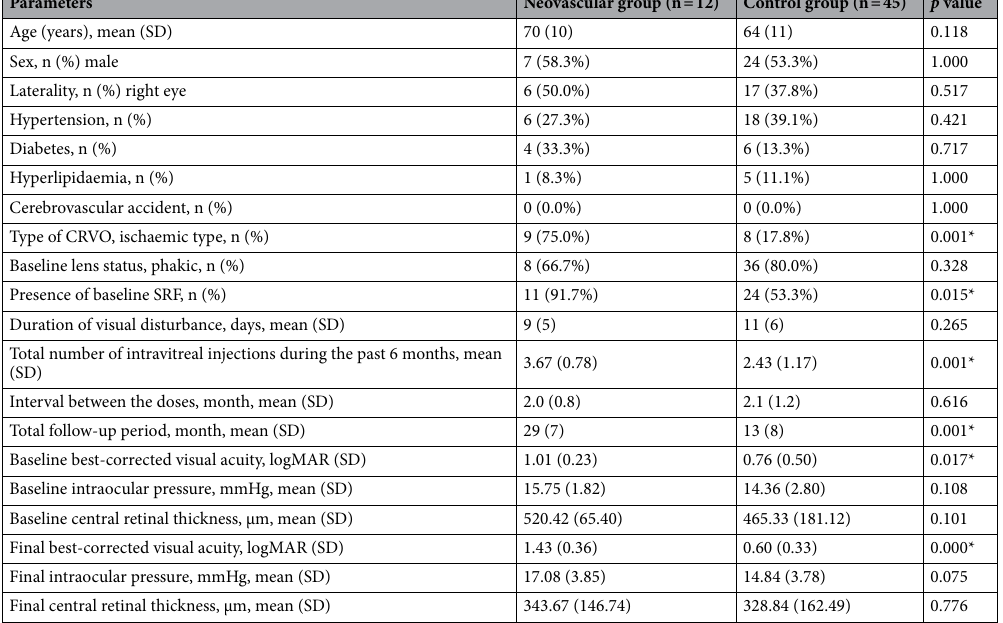
Table 1. Demographic and clinical characteristics of the neovascular and control groups among patients with central retinal vein occlusion. CRVO central retinal vein occlusion, SRF subretinal fluid. *Statistically significant by independent two-sample t-test or Pearson’s chi-square